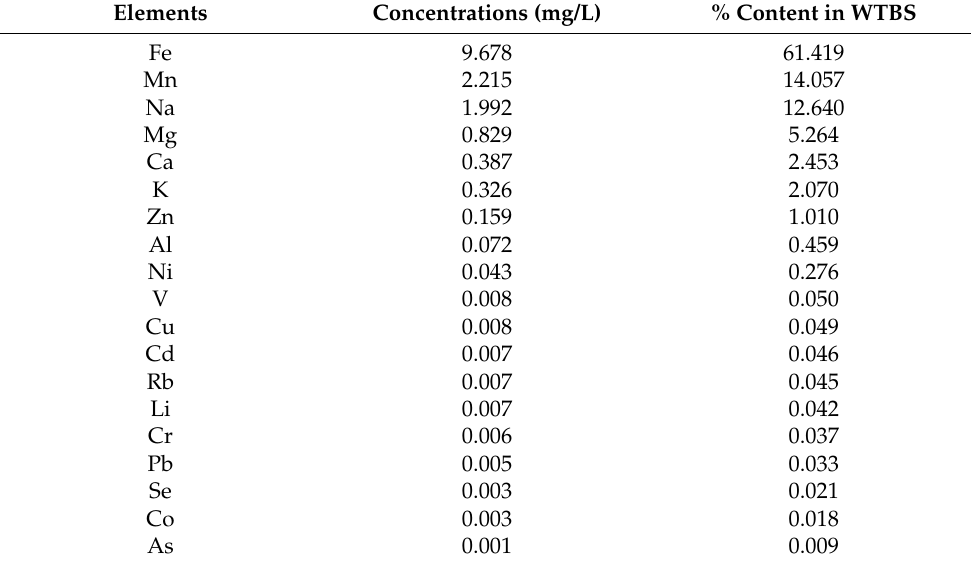
Table 2. Elemental compositions of the WTBS.